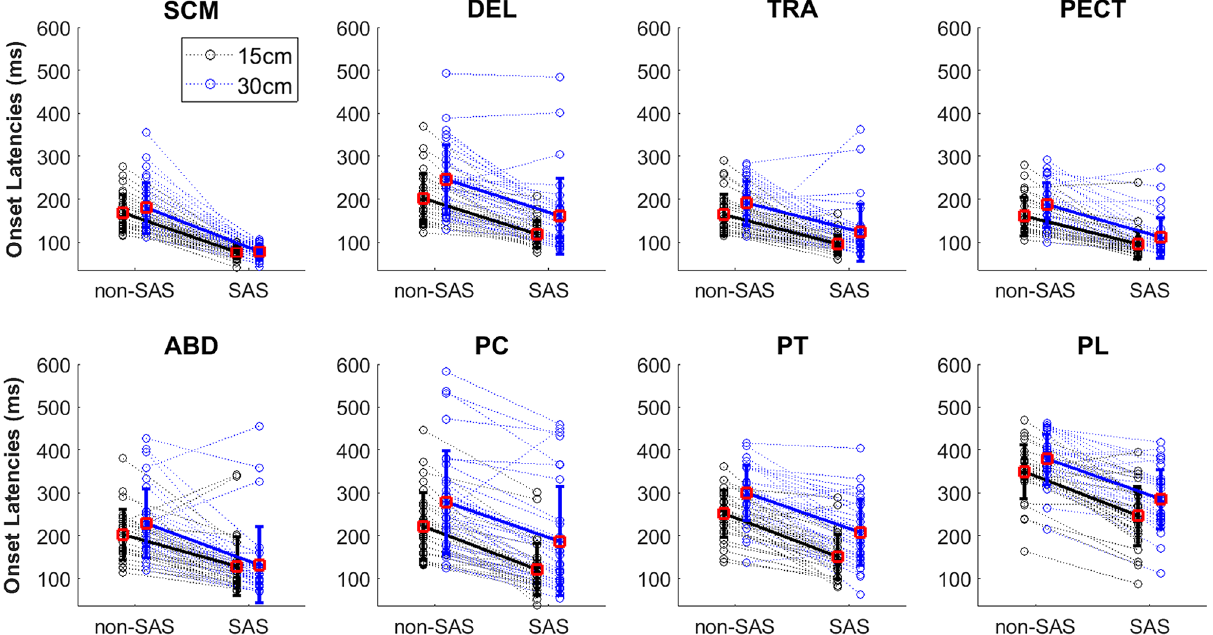
Figure 5. Onset latencies for the eight muscles and all the subjects, during the trunk movement task in non- SAS and SAS trials, at 15 cm (black) and 30 cm (blue). Each dotted line represents one subject, while the mean values are shown in wider lines, with error bars corresponding to the standard deviation.